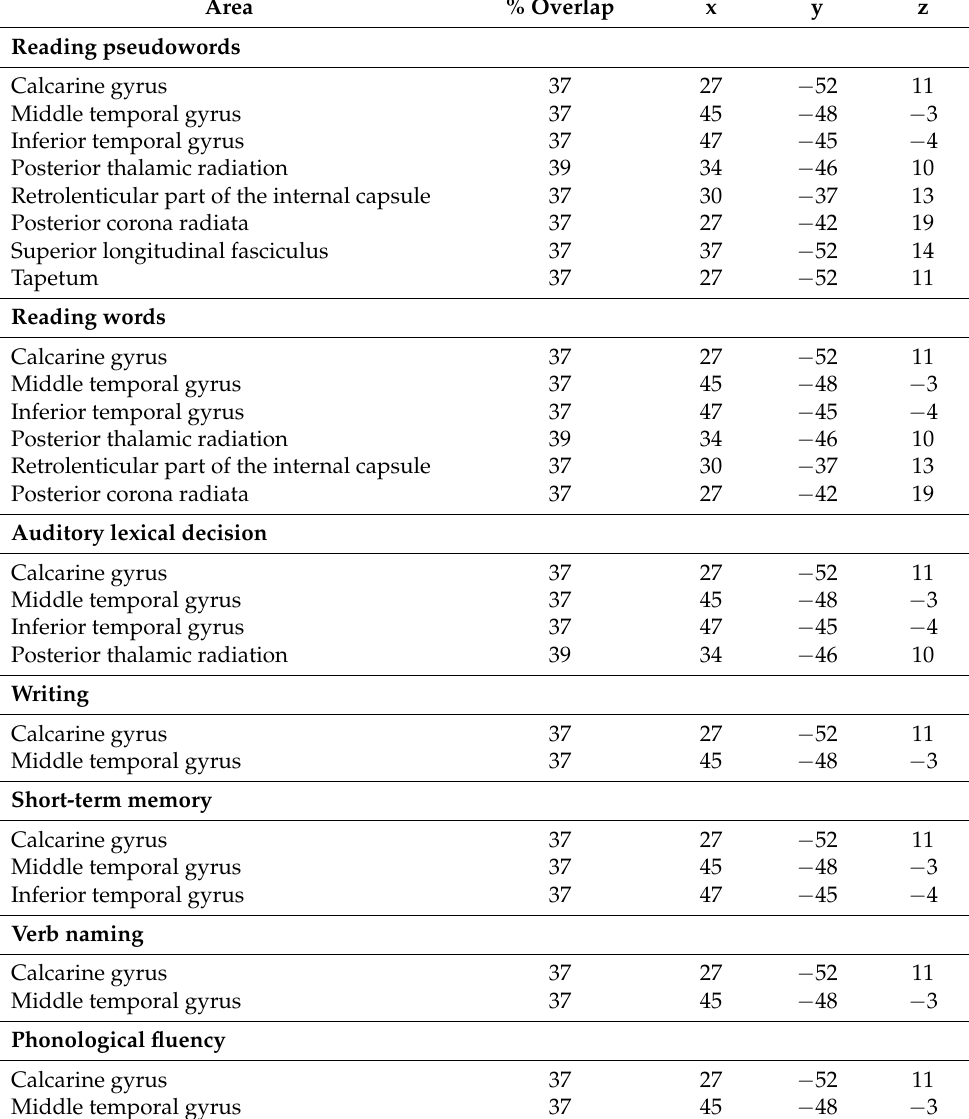
Table 5. Subtraction analysis was performed for each cognitive test. Local maxima are reported